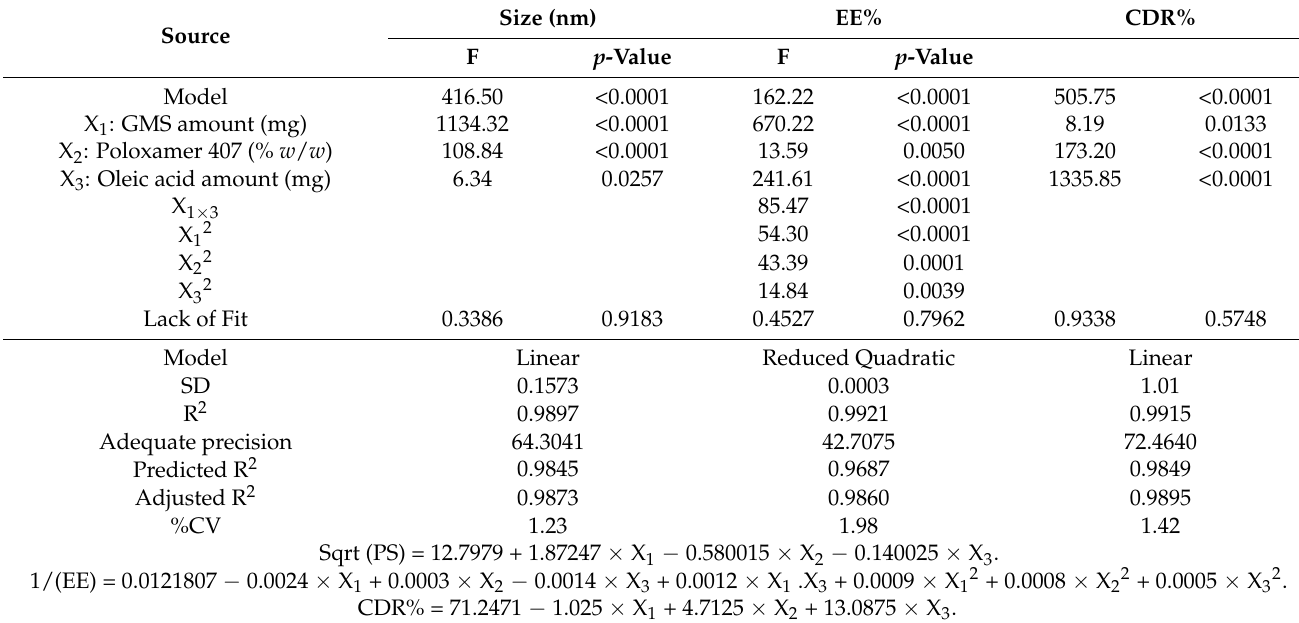
Table 2. The design expert results of all response